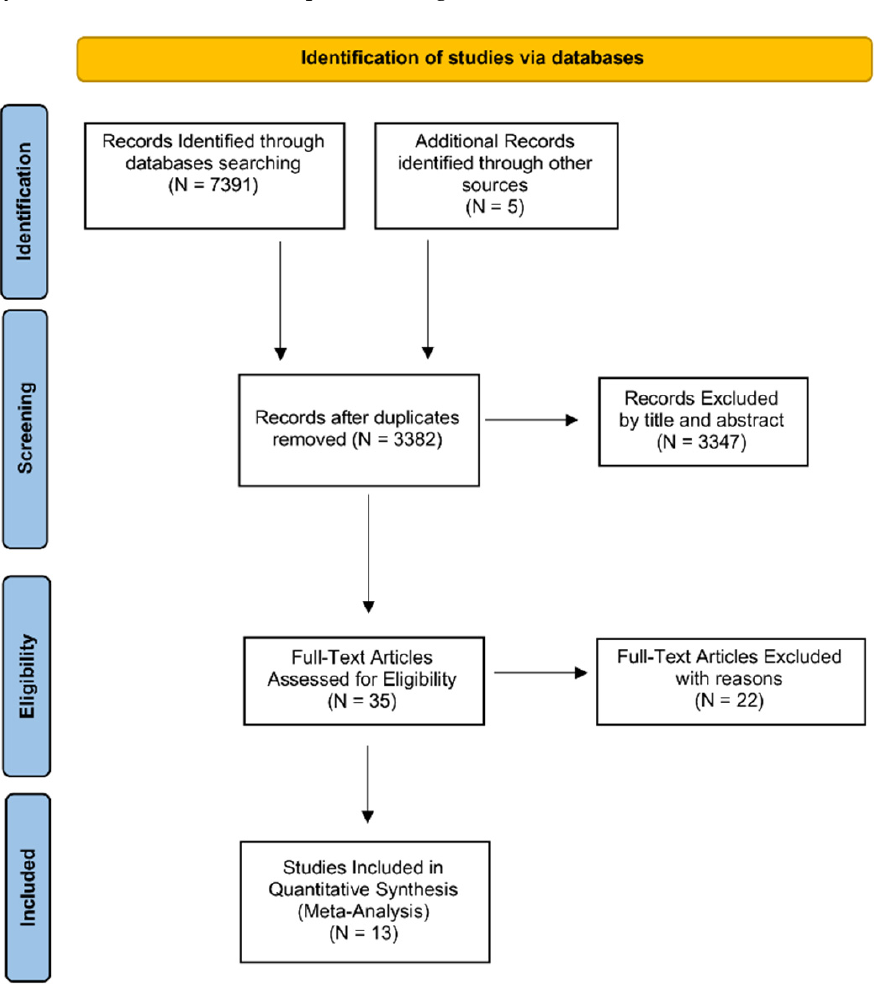
Figure 1. PRISMA Flow Diagram. The figure illustrates the PRISMA Flow Diagram for Search. The flow diagram was created according to PRISMA-P guidelines.